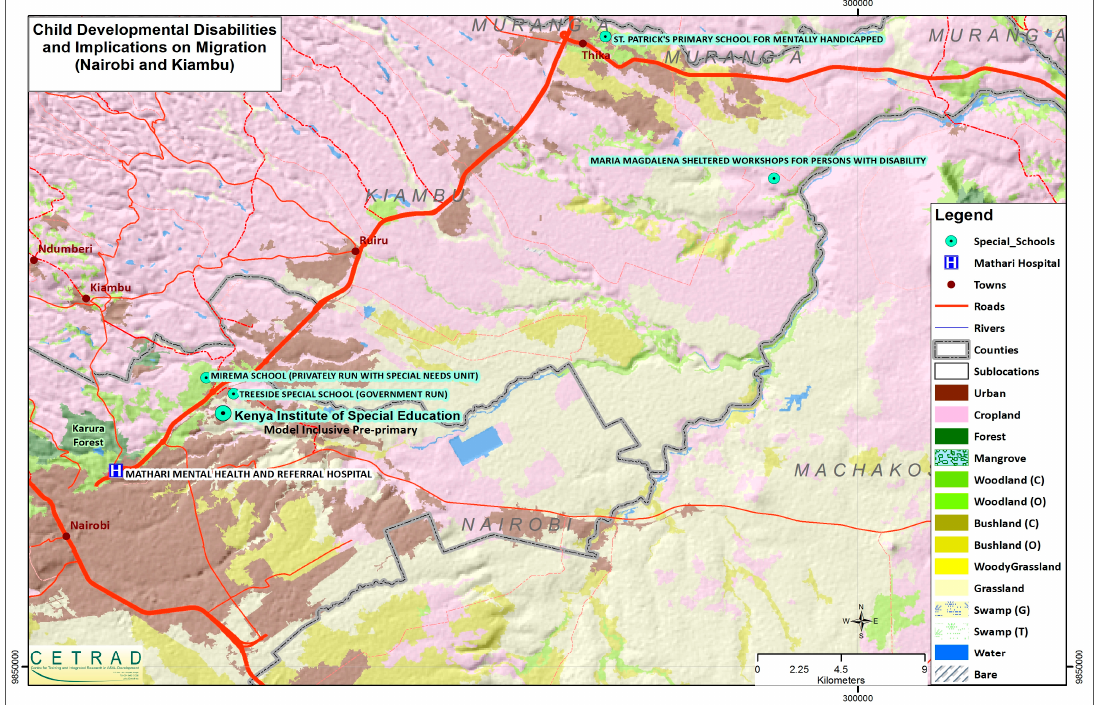
Figure 1. Map of area showing key institutions that deal with developmental disabilities.